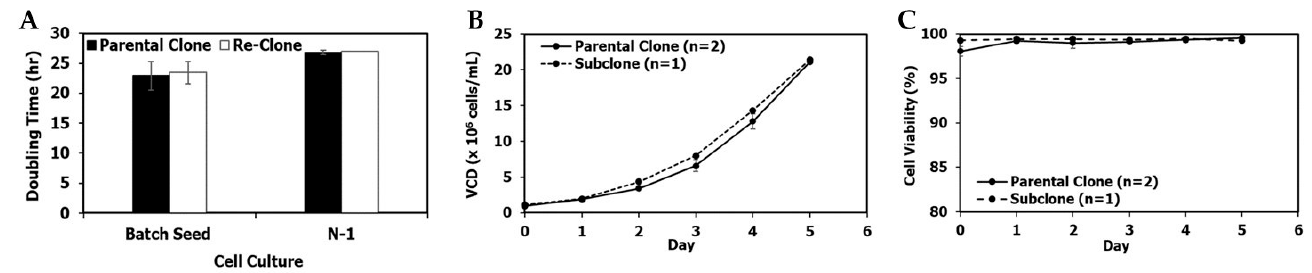
Figure 2. mAb1 seed and N-1 culture performance of the parental and re-clone. ( A ) Doubling times for the shake flask batch seed cultures and the N-1 5-L cultures, ( B ) N-1 fed-batch 5-L bioreactor viable cell density (VCD), ( C ) N-1 viability. The values are reported as average ± difference/2 (n = 2).